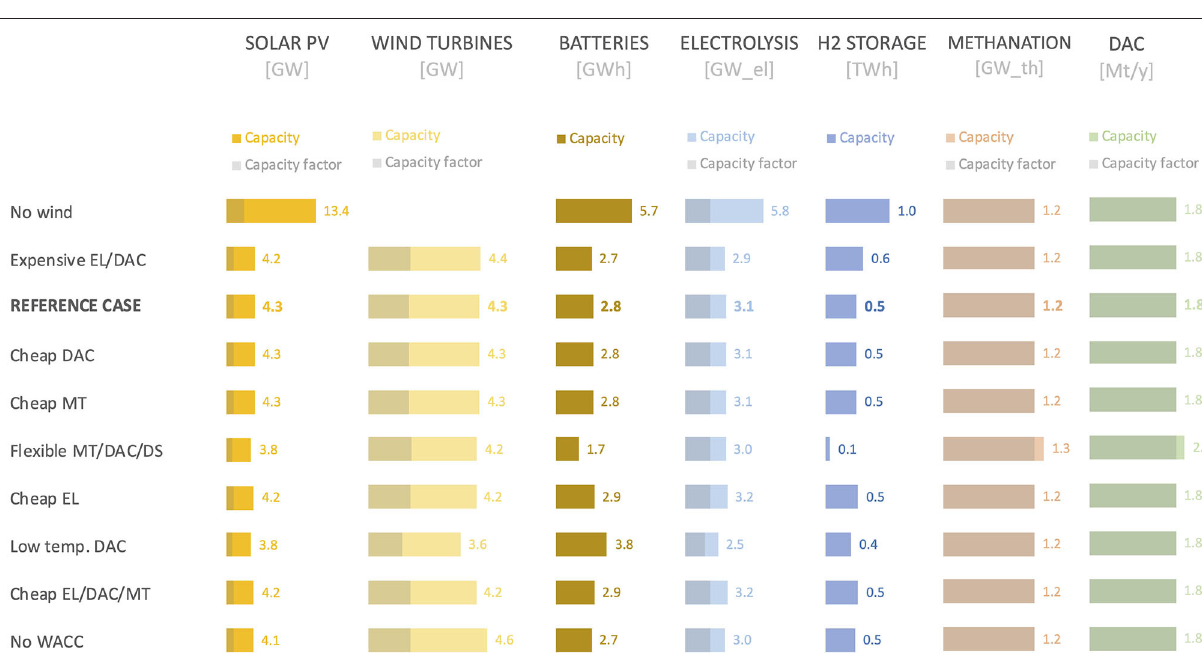
FIGURE 9 | Capacities and average capacity factors (shown as greyed fractions of capacity bars) of key conversion and storage technologies under various techno-economic